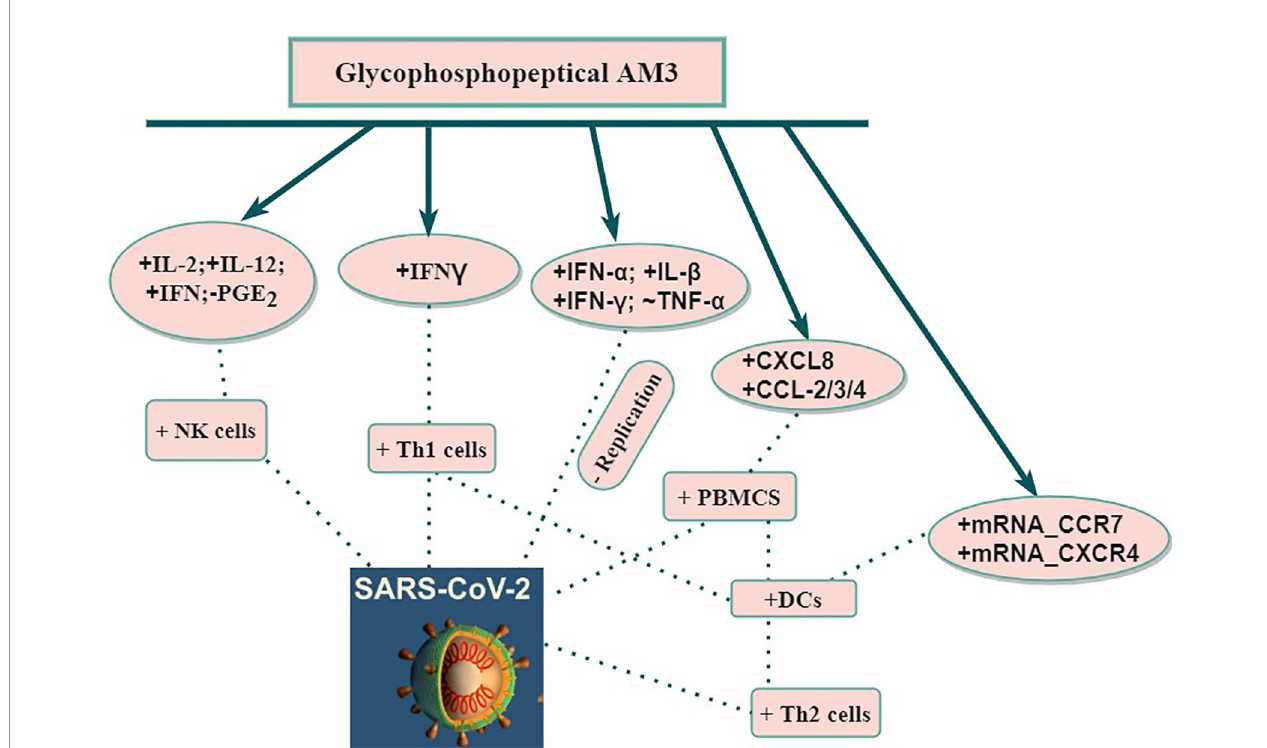
FIGURE 1 | Potential of use AM3 on immune response against SARS-CoV-2. CCL, Chemokine (C-X-C motif); CCR, Chemokine (C-C motif) Receptor; CXCL, Chemokine (C-X-C motif) Ligand; CXCR, Chemokine (C-X-C motif) Receptor; DCs, Dendritic cells; IFN, Interferon; IL, Interleukin; mRNA, Messenger RNA; NK, Natural Killer; PBMCS, Peripheral blood mononuclear cells; PGE, Prostaglandin; SARS-CoV-2, Severe Acute Respiratory Syndrome-2; Th1, T helper 1; Th2, T helper 2; TNF, Tumor Necrosis Factor; +, Stimulation; -, Inhibition; ~,